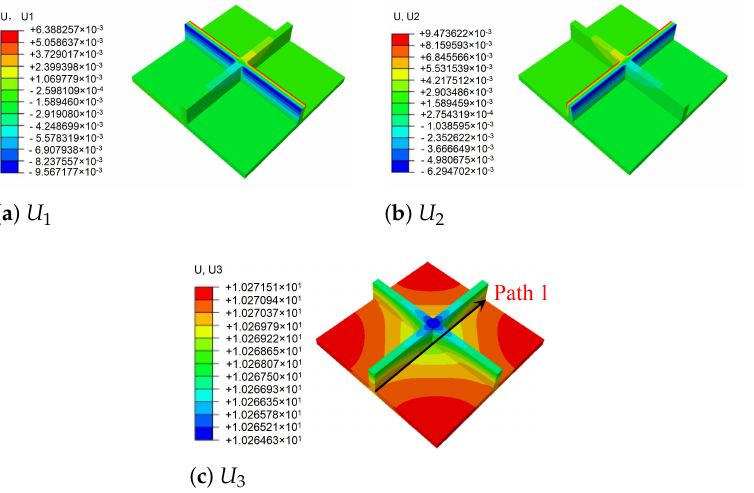
Figure 8. Local displacement fields within the unit cell at the geometric center of the plate (unit: